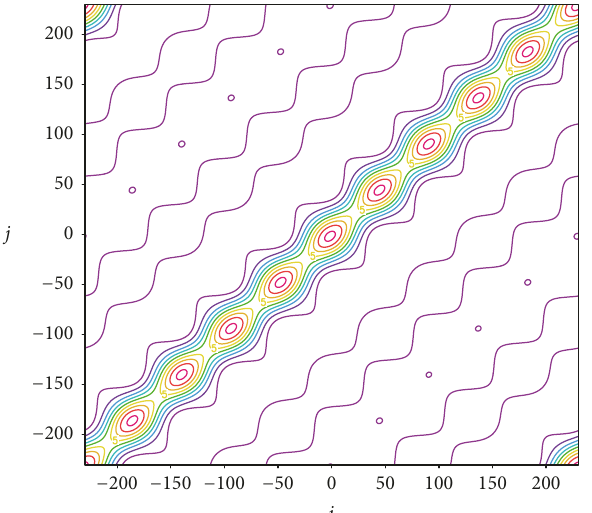
Figure 3: Structure of benchmark A plotted by color contours every 1m 2 s −2 for the case in Figure